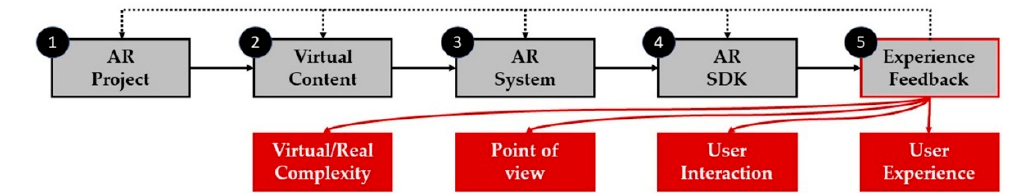
Figure 14. Block diagram of the main features of the AR feedback Experience.